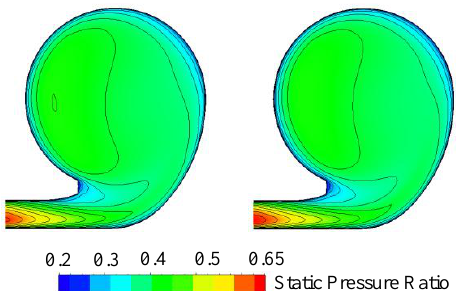
Figure 22. Distribution of relative Maher number of 0-0 section of the volute ( left : plain, right :